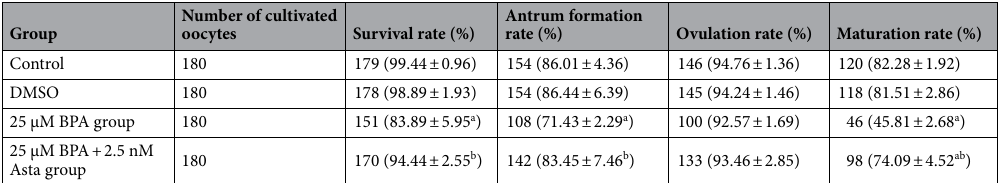
Table 1. The in vitro development of mouse follicles. Compared with control, a P < 0.05; and compared with the 25 µM BPA group b P <